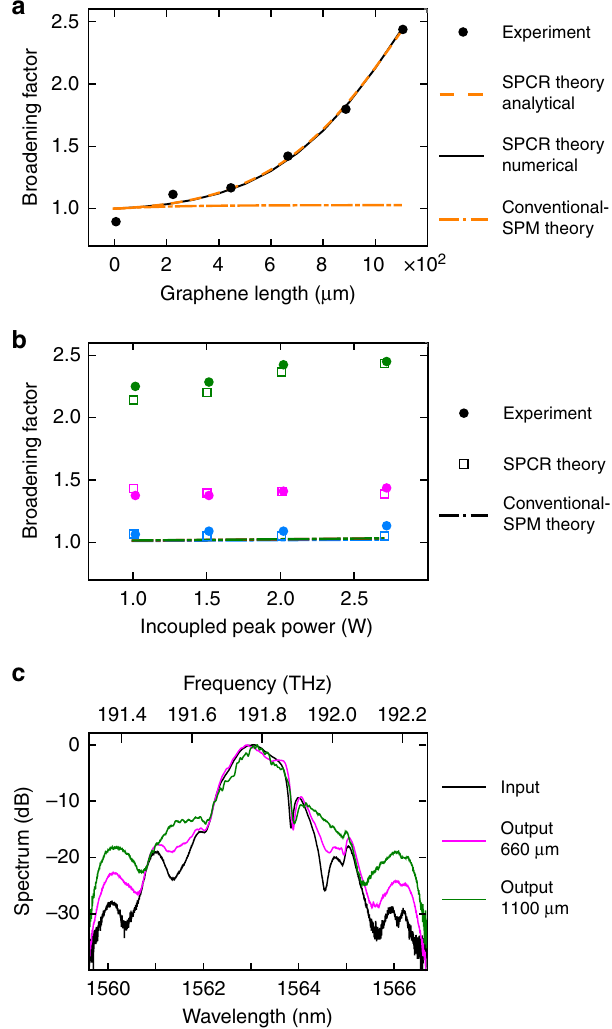
Fig. 2 Results of the broadening experiments. a Broadening factor as a function of graphene length for an incoupled peak power of 2.7 W. b Broadening factor as a function of incoupled peak power indicated in blue, magenta, and green for graphene lengths of 220, 660, and 1100 μ m, respectively. Both graphs show the experimental data points (with a measurement error below 5 %), the results from our saturable photoexcited-carrier refraction (SPCR) theory (numerical solution from Eqs. (4) and (5), and analytical solution from Eq. (6)), and the results from the theory for conventional self-phase modulation (SPM) using graphene ’ s strong effective χ eff (3) = − 10 − 7 esu as extracted from earlier experiments. c Normalized experimental input spectrum and output spectra for graphene lengths of 660 and 1100 μ m excited with an incoupled peak power of 2.7 W. The spectra are normalized to their respective peak power ¼ þ 0 : 2 (Fig. 3a). Hereto, we make use of our pulse-chirp control method which is explained in Methods. Using this newly